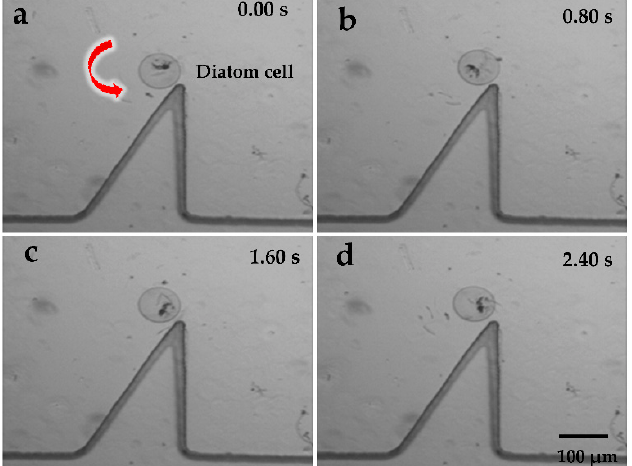
Figure 7. ( a – d ) Rotational manipulation of the diatom cell at 4.6 kHz and 20 V p-p .